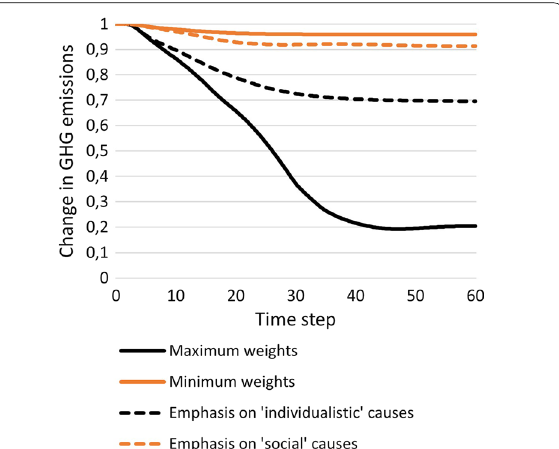
Fig. 5 Full set of interventions under alternative feedback effect